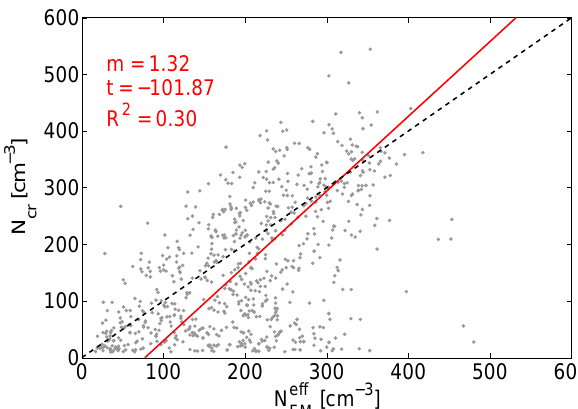
Fig. 12. Number concentrations of cloud residuals ( N cr ) deduced from two SMPS systems and corrected for particle losses as de- scribed in Sect. 2.2.4 versus cloud droplet number concentra- tion measured by the FM-100 corrected for particle losses using ASP09TR – see Table 3 – for all data ( N eff FM